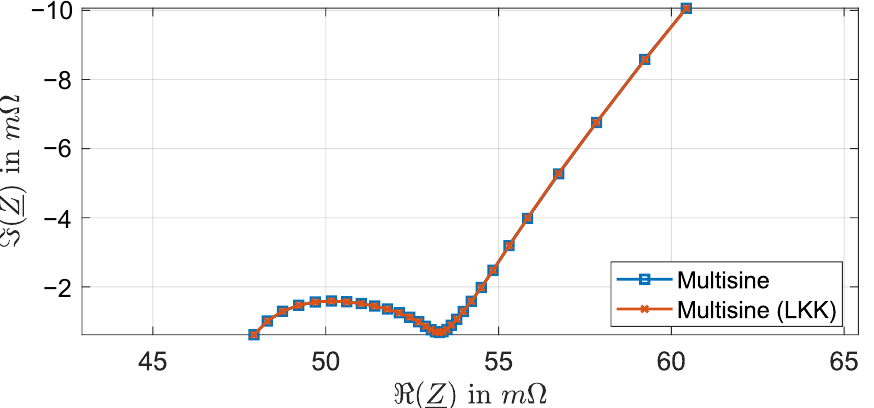
Figure 13. Measured and linear Kramers-Kronig-calculated impedance spectrum of the Lithium-ion battery cell after excitation by the multisine signal generated by the proposed method.